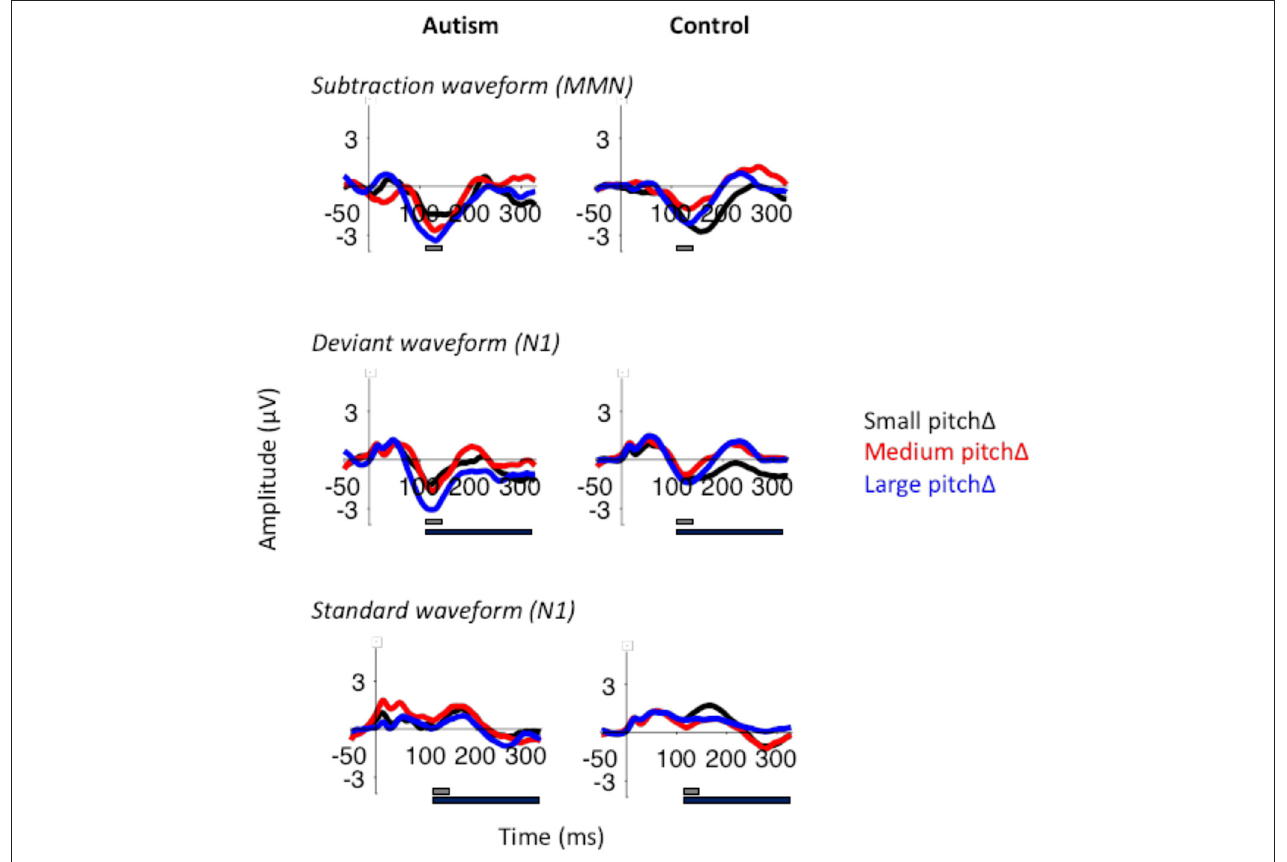
FIGURE 6 | MMN (top), deviant N1 (middle), and standard N1 (bottom) to the small, medium, and large pitch changes (black, red, and blue respectively) in autism (left) and neurotypical controls (right). The gray bar indicates the window used for the peak amplitude analysis. The black bar indicates the window used for the TTV analysis. N1 was larger in response to the large pitch changes, but there were no significant differences between the